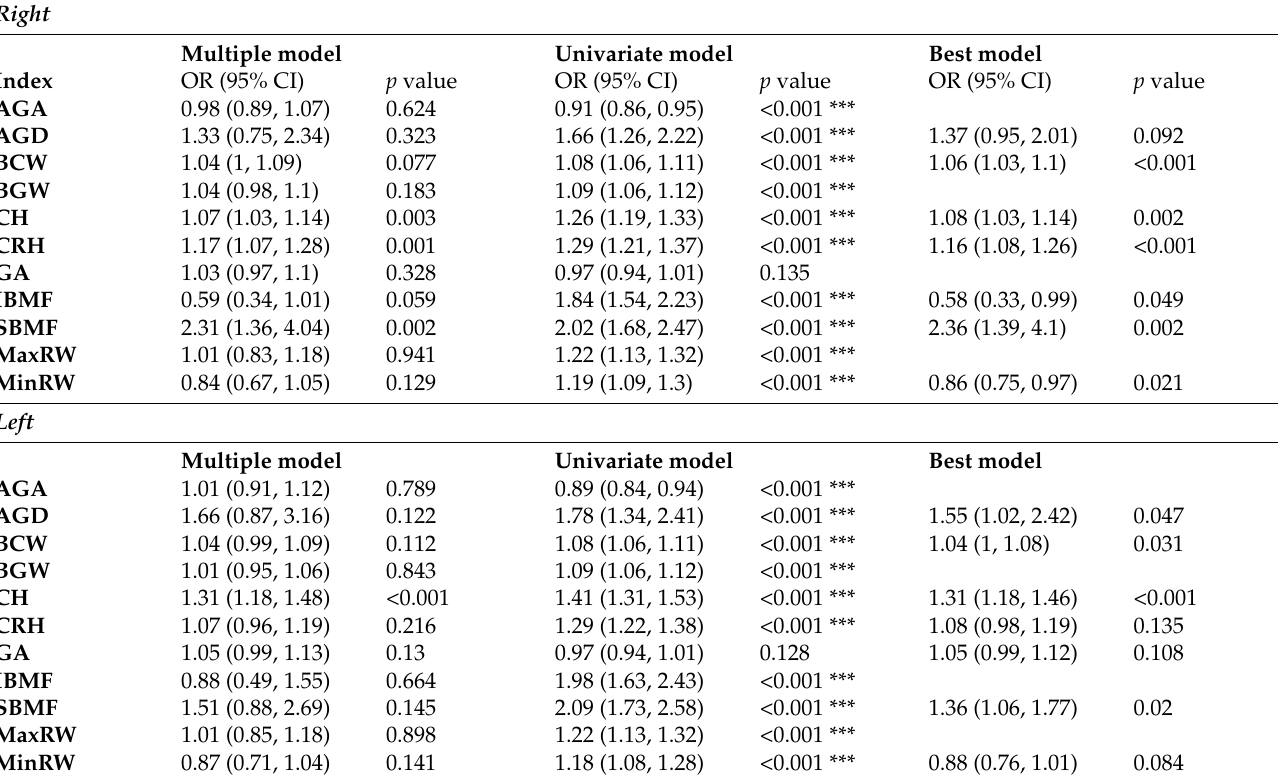
Figure 3. Mean values (degree) of gonial and antegonial angles in males and females. Table 1. Results obtained in univariate, multiple, and best